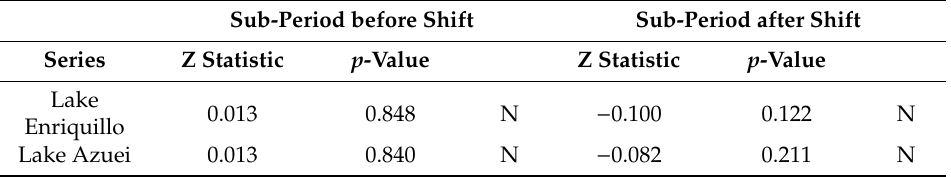
Table 3. Result of Mann-Kendall trend analysis after applying the change point.